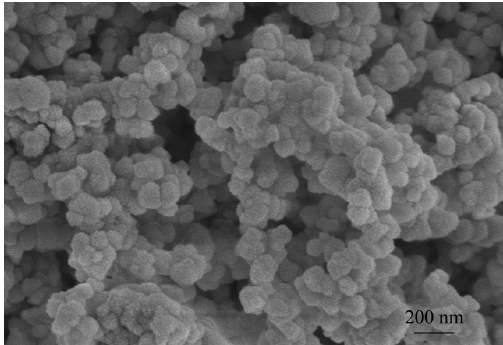
Fig. 1 Morphology of zirconia powder observed by scanning electron microscopy (SEM).